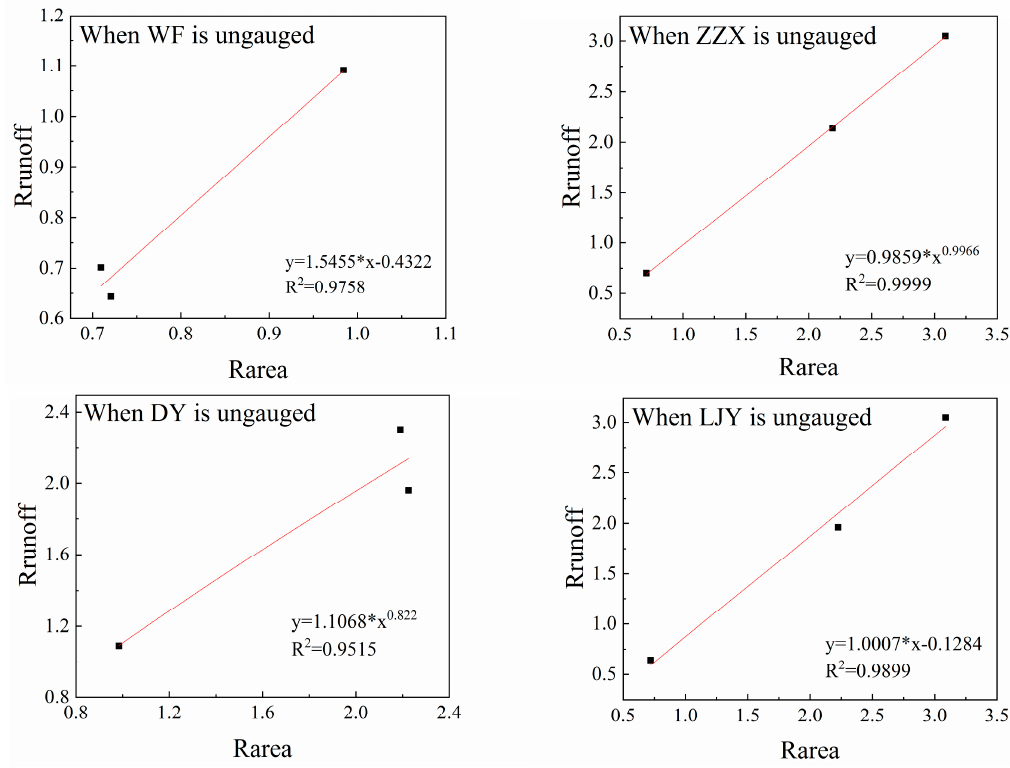
Figure 3. The correlation between the area ratio and the runoff ratio of the four gauged catchments in group PC1.